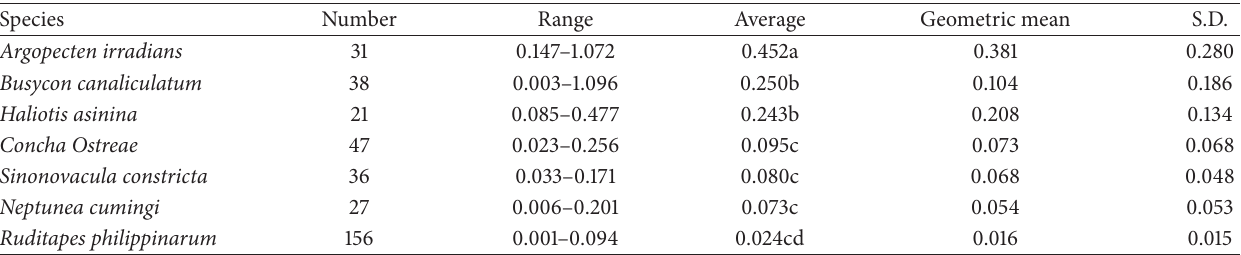
Table 1: Hg contents in the different species of shellfish samples (wet weight, mg ⋅ kg −1 ).